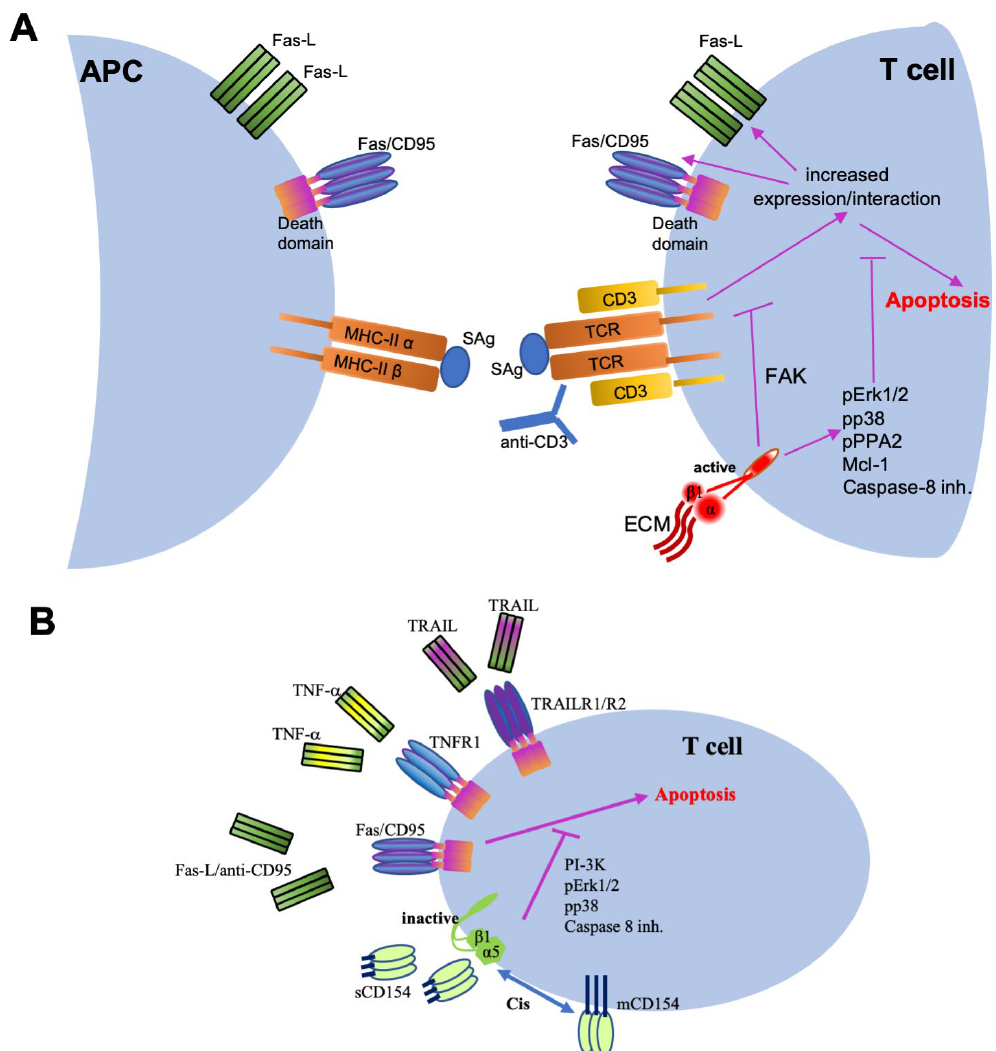
Figure 3. Mechanistic of the apoptosis-inhibiting role of β 1 integrin–ECM and α 5 β 1–CD154 dyads: ( A ) activating TCR/CD3 via binding to Sag–MHC–II complex (which binds to the variable region of the TCR β chain and activates T cells without being processed by APCs) or to anti-CD3 Abs, in a process termed activation-induced cell death (AICD), enhances surface expression of Fas and Fas ligand on T cells, thus promoting cell apoptosis. Binding of extracellular matrix (ECM) ligands or activating antibodies to β 1 integrins abrogates this AICD by inducing signaling events such as activation of FAK, ERK1/2, and PPA2 and maintaining the survival signal, Mcl-1, leading to caspase-8 inhibition; ( B ) binding of sCD154 to α 5 β 1 integrin inhibits apoptosis induced by Fas–FasL interaction, as well as by other death signals—namely, TNF- α and TRAIL, interacting with their respective receptors via activating survival signals including PI-3K, ERK1/2, and p38 to also lead the inhibition of caspase-8 cleavage. The α 5 β 1 is capable of interacting with sCD154, as well as with mCD154, but in a cis-manner of binding (when both ligand and receptor are expressed on the surface of the same cell). Abbreviations: APC, antigen-presenting cell; ERK, extracellular-signal-regulated kinase; FAK, focal adhesion kinase; Mcl-1, myeloid cell leukemia-1; MHC-II, major histocompatibility complex II; PI-3K, phosphoinositide-3 kinase; PPA2, protein phosphatase A2; SAg, superantigen; TNF- α , tumor necrosis factor- α ; TNFR1, TNF receptor 1; TRAIL, TNF-related apoptosis-inducing ligand; TRAILR1/R2, TRAIL receptors R1 and R2; TCR, T-cell